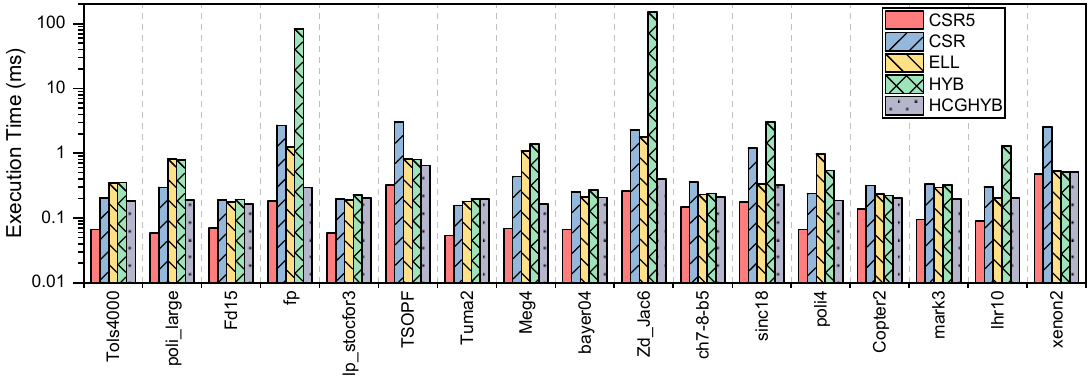
Figure 21. HCGHYB execution time compared to CSR, ELL, HYB, and